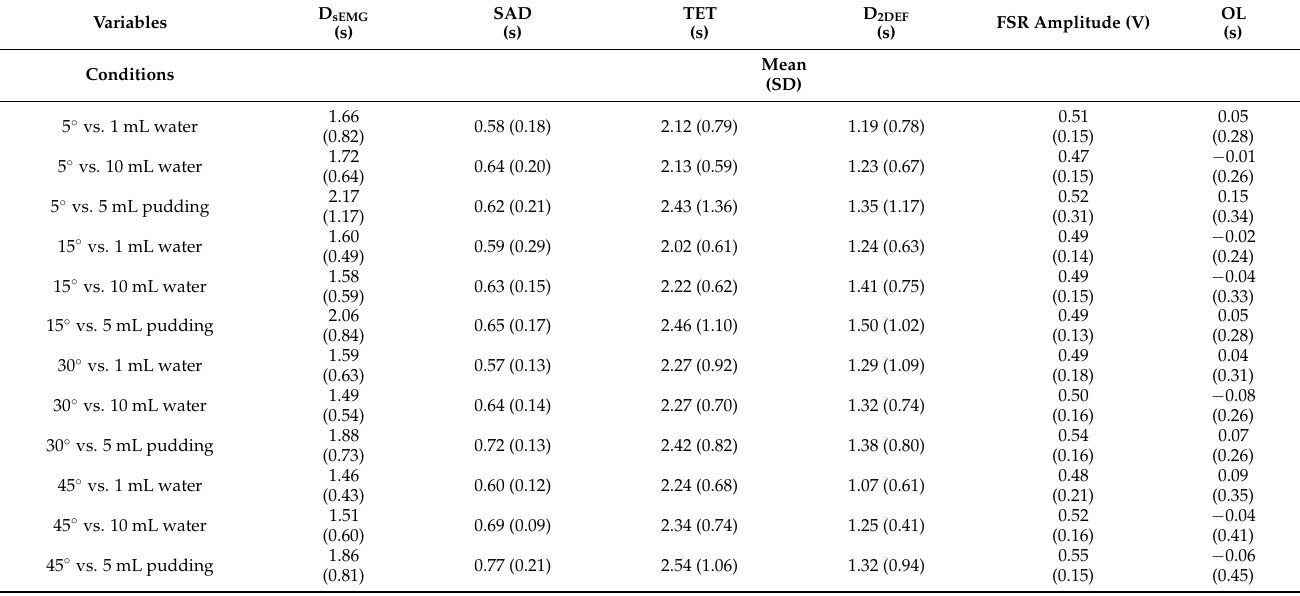
Table 3. Descriptive statistics of each variable under different inclination angles and food